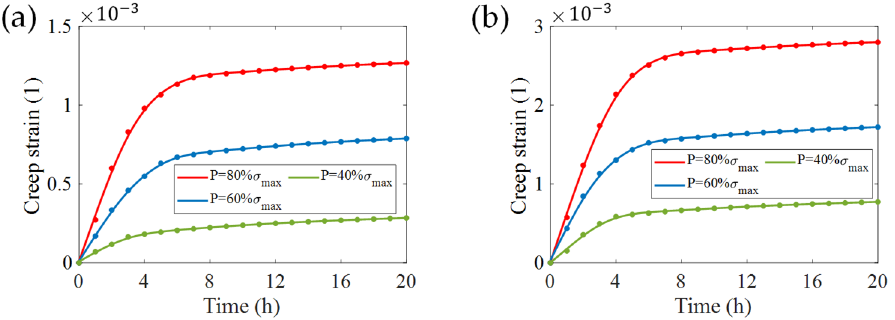
Figure 11. Creep strain induced by varying stress load for ( a ) transverse textures and ( b ) the side- wall profile of sensitive grids in the conditions of with 𝐵/𝑇 (cid:3034) (cid:3404) 8% ( a ) and with 𝐴/𝑊 (cid:3034) (cid:3404) 8% ( b ).